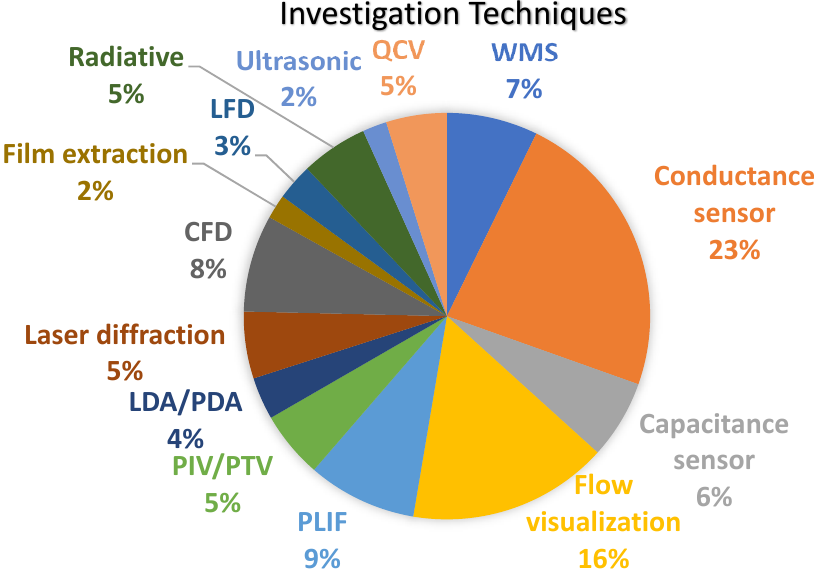
Figure 10. A summary of the major research techniques used in the investigation of the annular two-phase flow in the recent two decades.